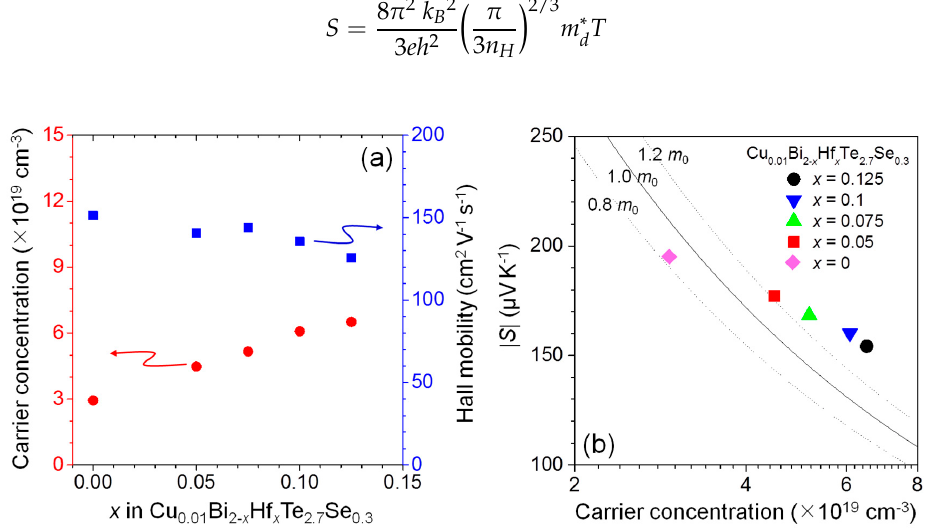
Figure 3. ( a ) Hall carrier concentration ( n H ) and Hall mobility ( μ H ) as a function of Hf ‑ doping content. ( b ) Pisarenko plot (l S l ‑ n H ) for the SPSed Cu 0.01 Bi 2 ‑ x Hf x Te 2.7 Se 0.3 ( x = 0, 0.05, 0.075, 0.1, 0.125) bulks.